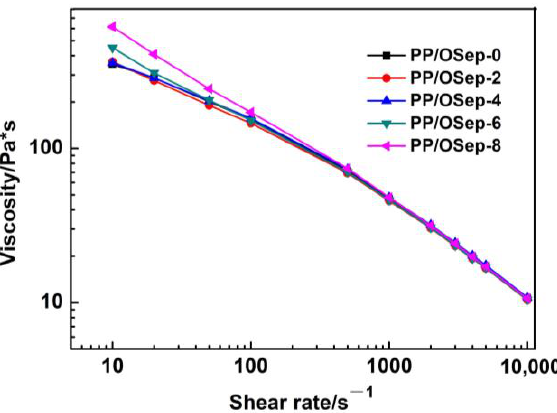
Figure 5. Viscosity of PP/OSep nanocomposites with different OSep contents.